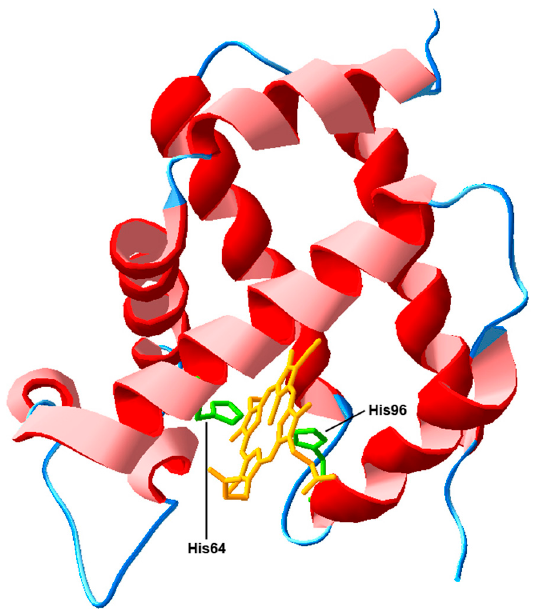
Figure 1. 3D protein structure of human neuroglobin (NGB; PDB code: 1OJ6) exhibiting the typical globin fold (see [18]). In green are represented the two histidine side chains (His64 and His96) interacting with the heme group represented in yellow. The most peculiar structural characteristic of NGB is the so-called six-coordinate binding scheme of the heme Fe atom. In the absence of external ligands, the His64 binds the heme iron at its sixth, distal position. Thereby, any external gaseous ligand such as O 2 or NO has to compete with the internal His64 ligand for Fe binding [19].